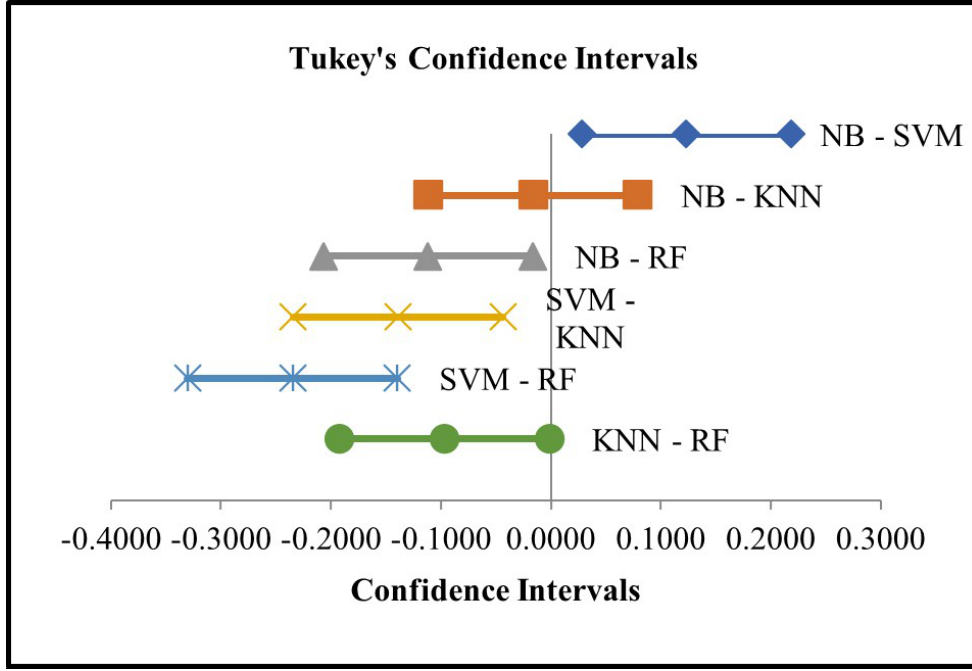
Figure 5. Multiple comparisons for prediction models using AUC. Table 17. Scenario AUC values for performance evaluation of RF with default and Mtry parameter